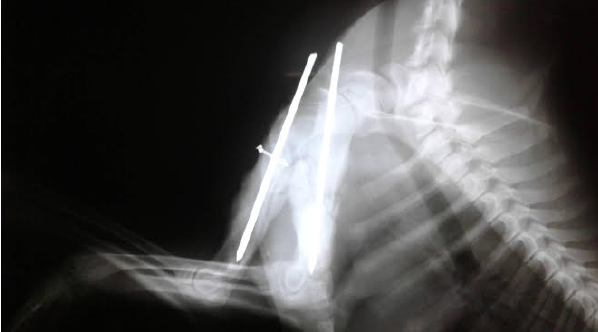
Fig. 16. Radiography in young dog showed secondary bone healing after 60 days of